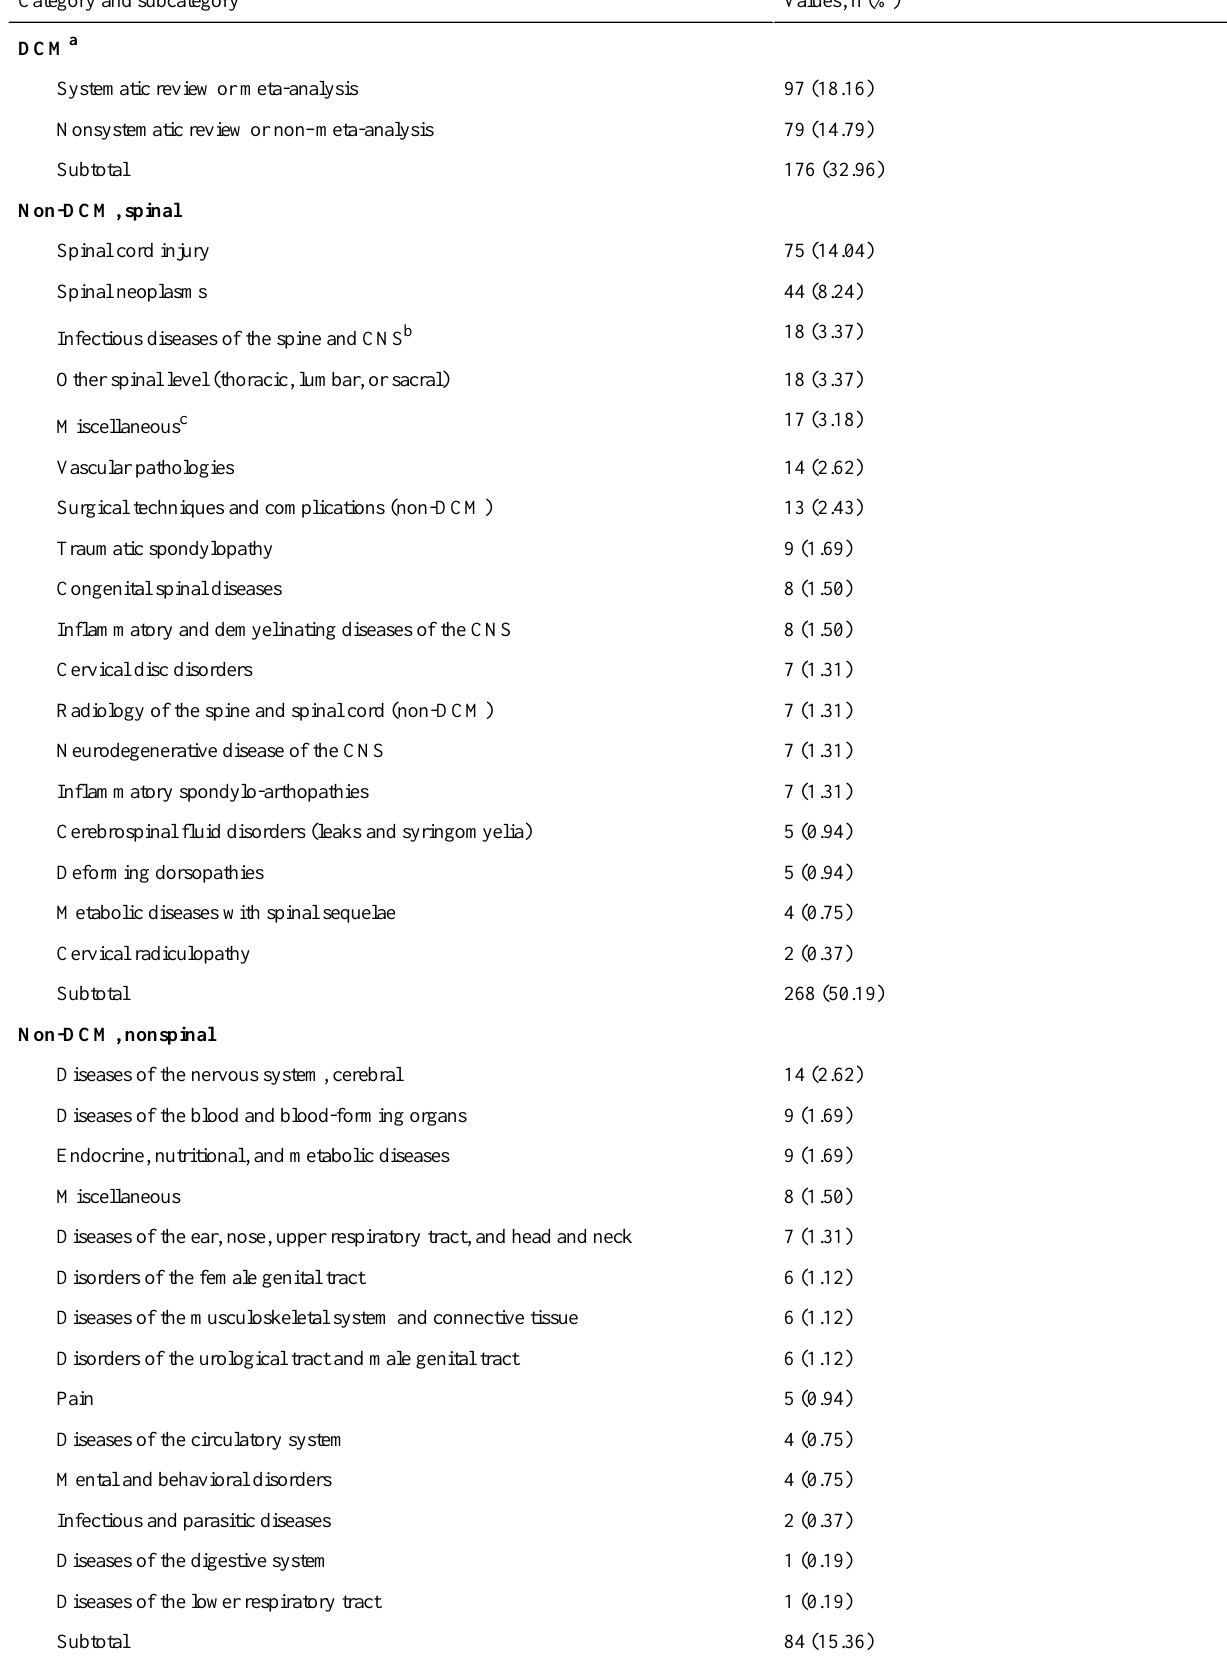
Table 1. Phase 2 search results categorization guided by the International Classification of Diseases 11th